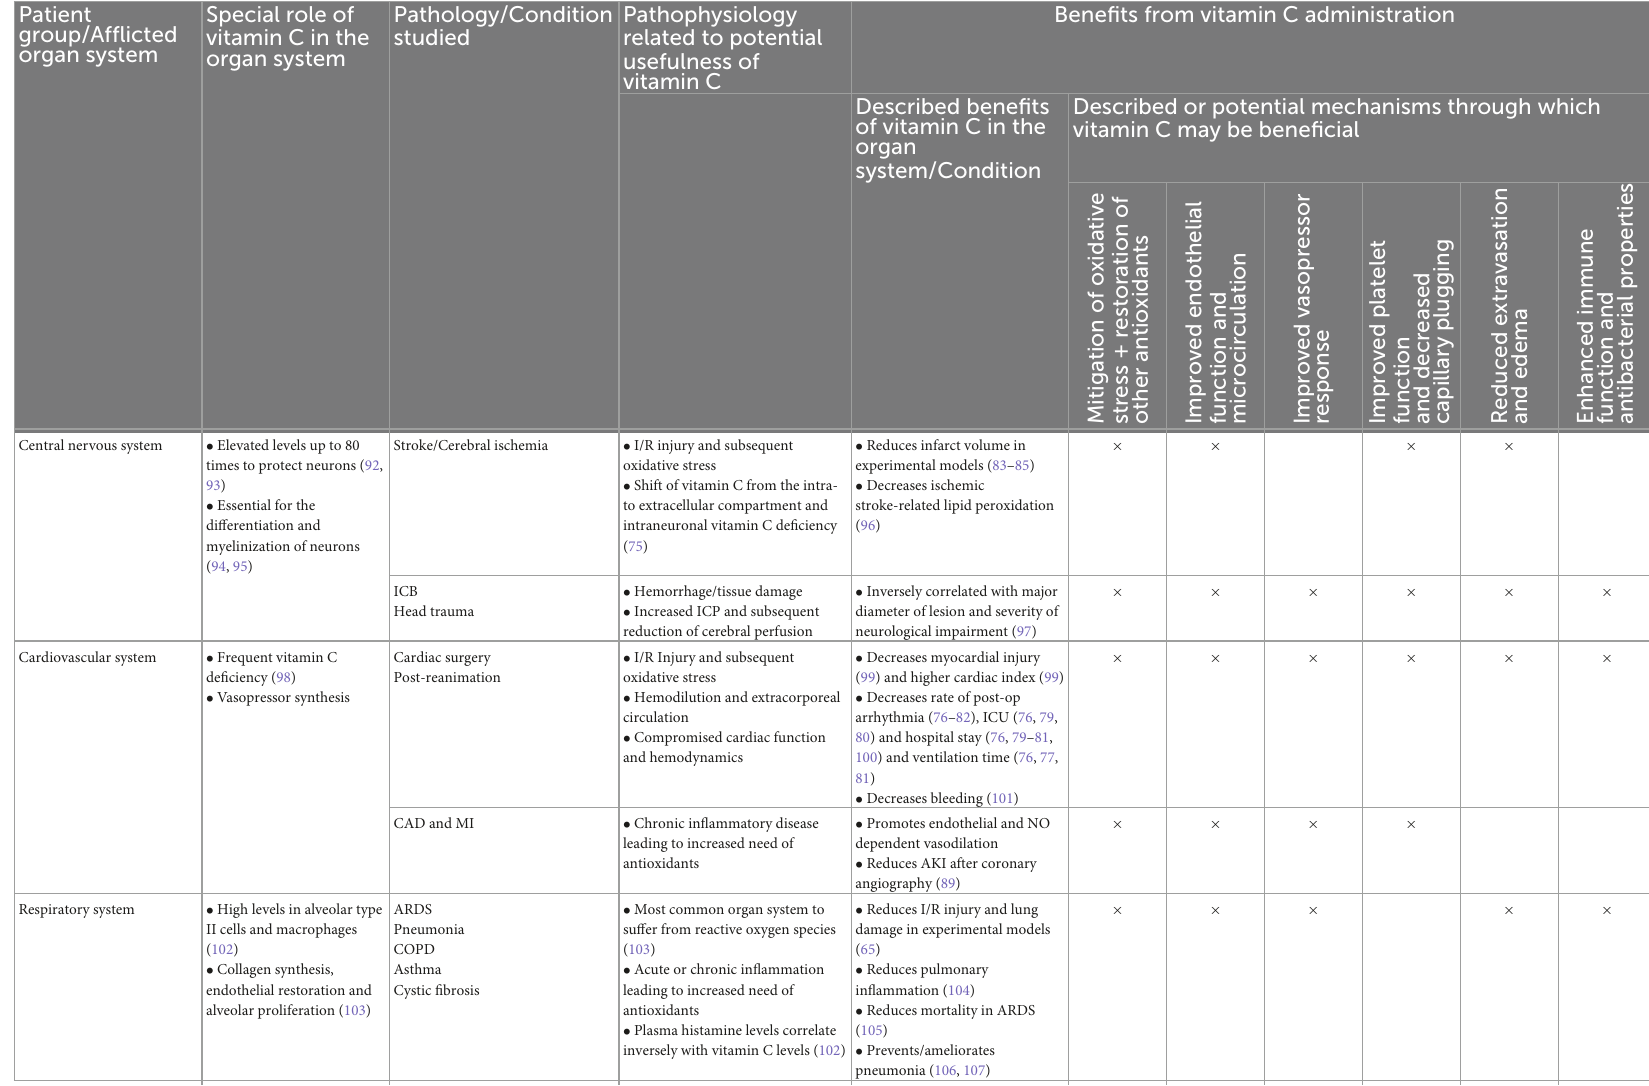
TABLE 3 Role and potential benefits of vitamin C on various organ systems, adapted from; all described benefits were derived from clinical studies unless stated explicitly. Patient